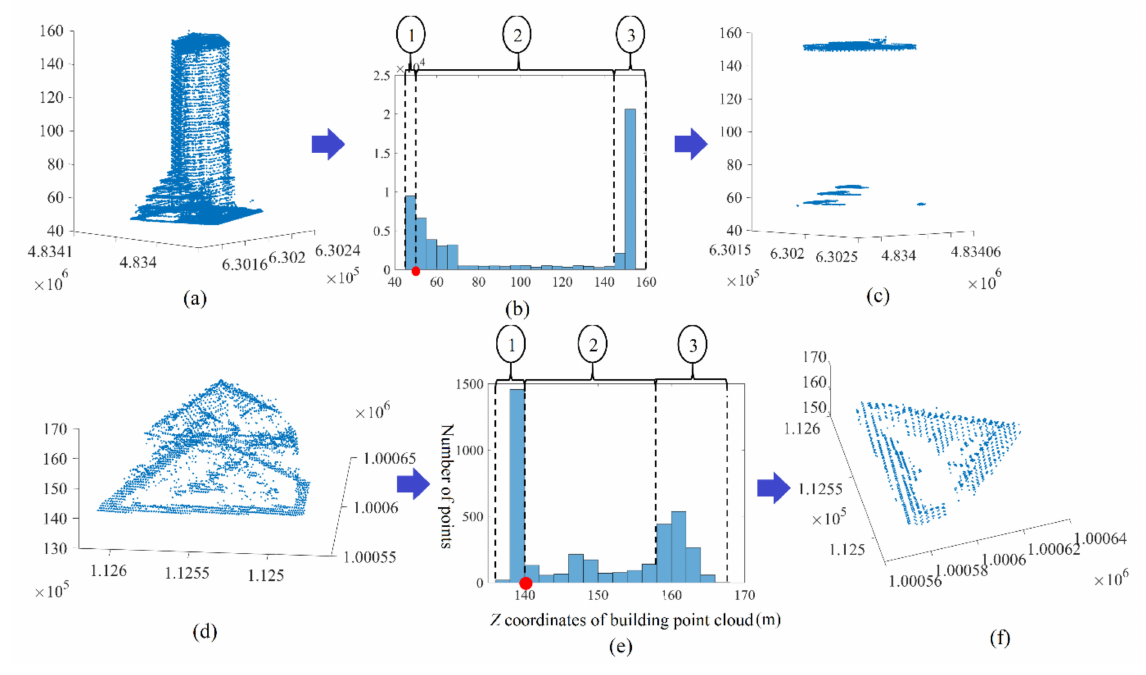
Figure 2. ( a , d ) Building point clouds, respectively, in Toronto and Strasbourg datasets; ( b , e ) his- tograms of Z coordinate of building point clouds consecutively of the last two buildings; ( c , f ) final results of building point clouds’ filtering; The red dots in ( b , e ) are the PSTF; “1,2,3” in circles in ( b , e ) are building section